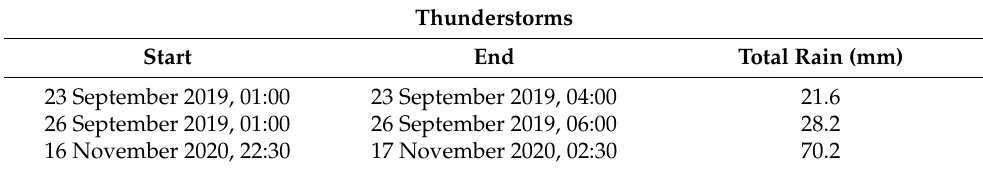
Table 2. Thunderstorms analysed in this study; rain amounts measured at MAFE station.